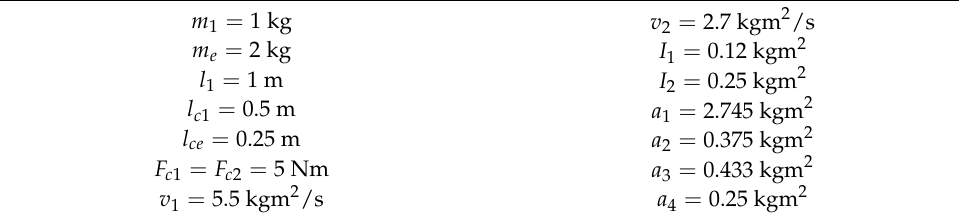
Table 2. Constant parameters of the upper-limb exoskeleton robot